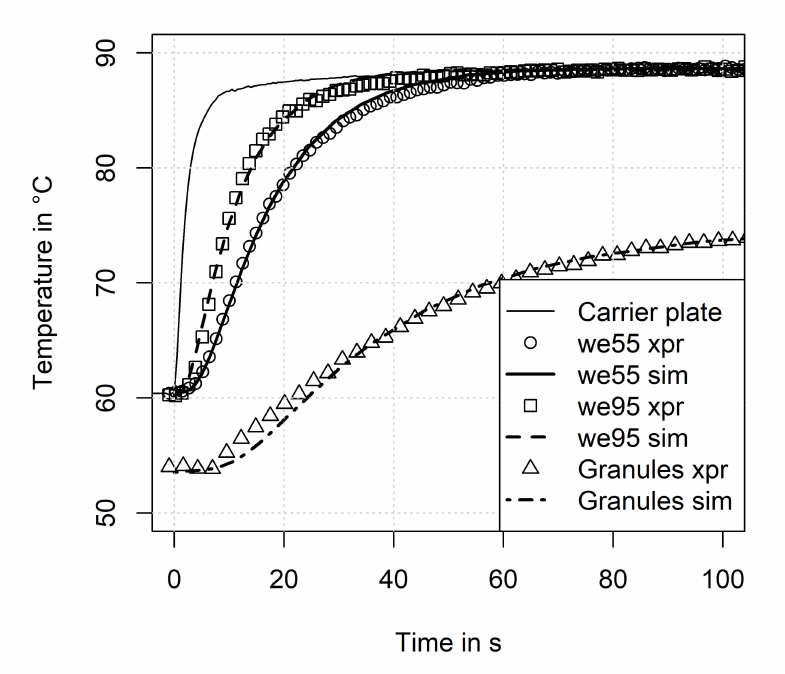
Figure 4. Measured (xpr) and simulated (sim) surface temperature for the samples “we55”, “we95”, and “Granules” after an inert large temperature jump of 60 → 90 ◦ C at t = 0 s under dry nitrogen atmosphere at 44 mbar absolute pressure. The measured temperature of the carrier plate is shown as well (“Carrier plate”). It is the same temperature for all